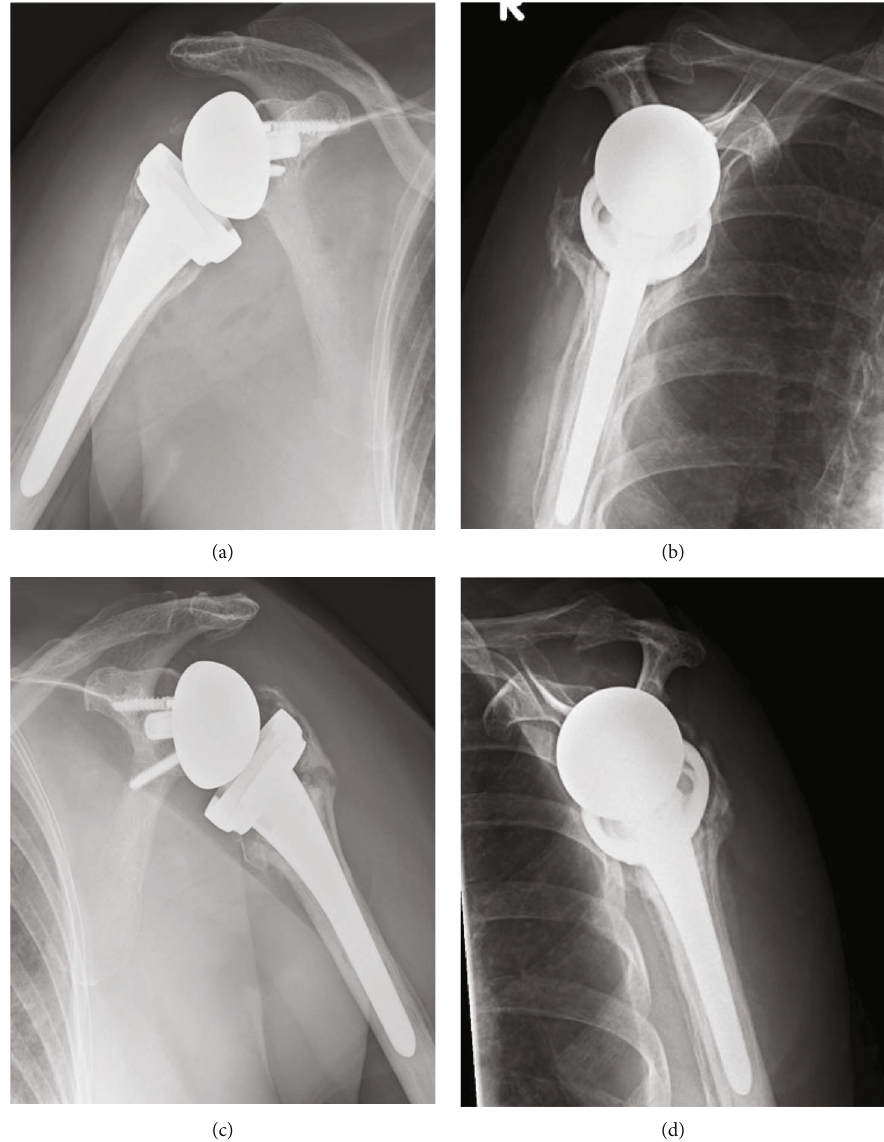
Figure 6: Radiographs showing both shoulders at the most recent follow-up: (a) Grashey view and (b) transscapular Y view of the right shoulder and (c) Grashey view and (d) transscapular Y view of the left